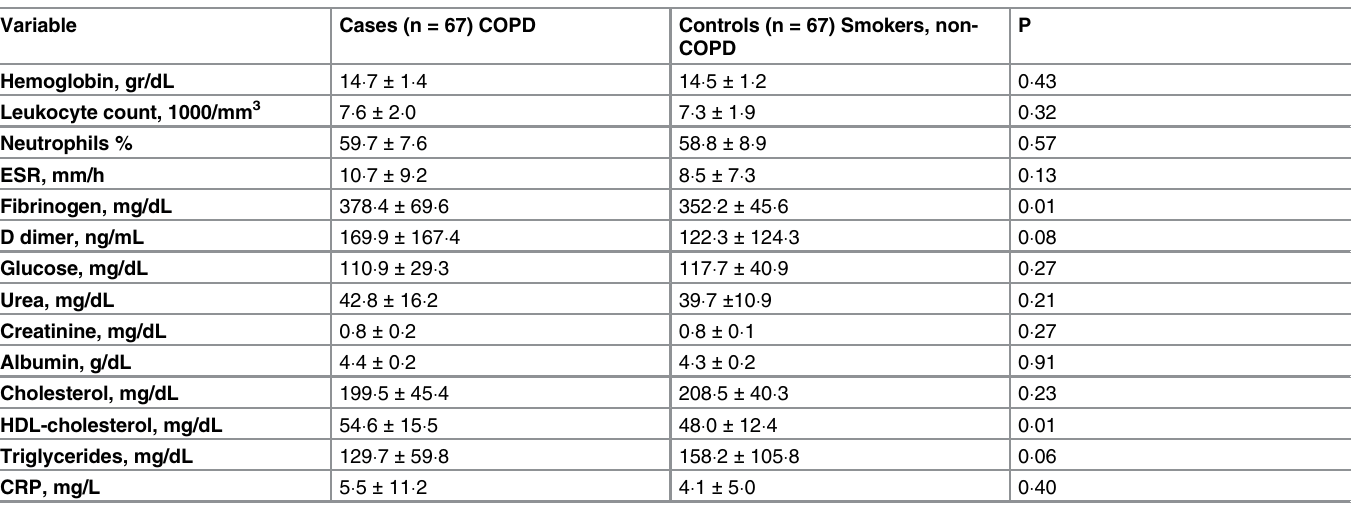
Table 4. Blood analysis